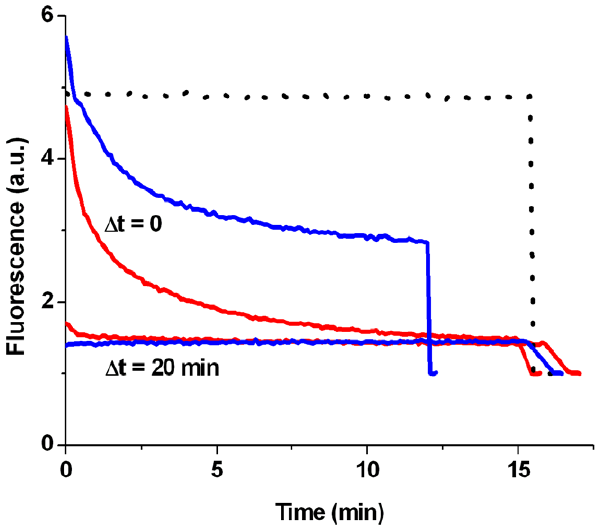
Figure 7. POPG LUVs encapsulating a 3 kDa dextran-PTS. In the presence of 5 mM Ca 2 + the 3Kda dextran-PTS remains in the vesicle interior. The quencher DPX was added D t after mixing the vesicles with oligomeric a S to a final concentration of 0.25 mM lipid and 1.5 m M a S. The amount of DPX influx is reduced upon increasing equilibration time ( D t=0, 0.5, 1, 5, 20 and 60 minutes). The dotted line is a background curve in the absence of protein. After approximately 15 minutes Triton X-100 is added to disrupt all vesicles, and all curves are normalized to the value obtained after Triton disruption.